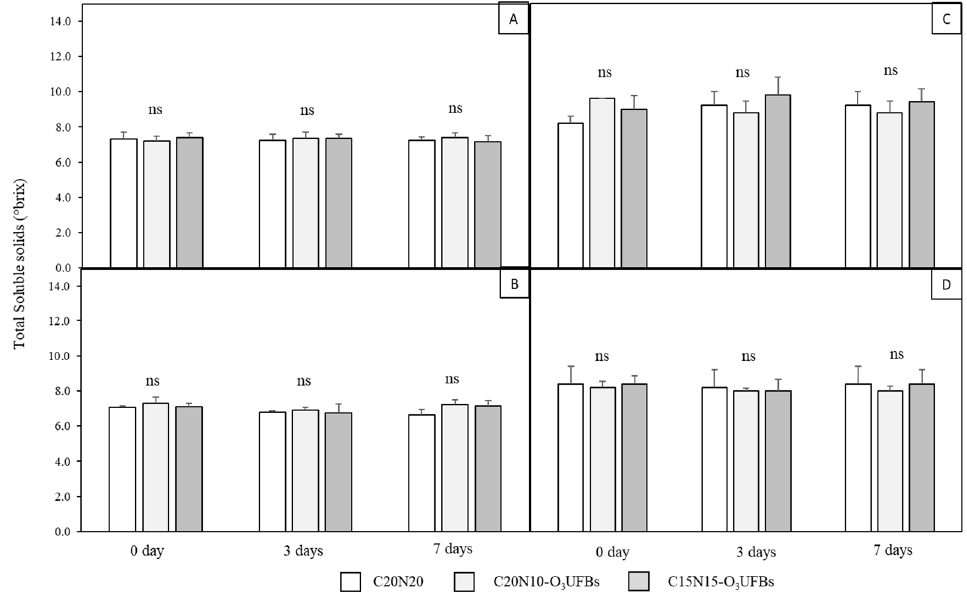
Figure 7. Total soluble solids (TSS) of coconut water ( A , B ) and coconut meat ( C , D ) for trimmed coconuts dipped in C 20 N 10 -O 3 UFBs and C 15 N 15 -O 3 UFBs compared with C 20 N 20 when stored at 2 °C for 0 days (before storage) ( A ) and 30 days ( B ). After storage, all coconut fruits were transferred to 8–10 °C for 7 days and TSS were evaluated on days 0, 3, and 7. ns: not significantly different.